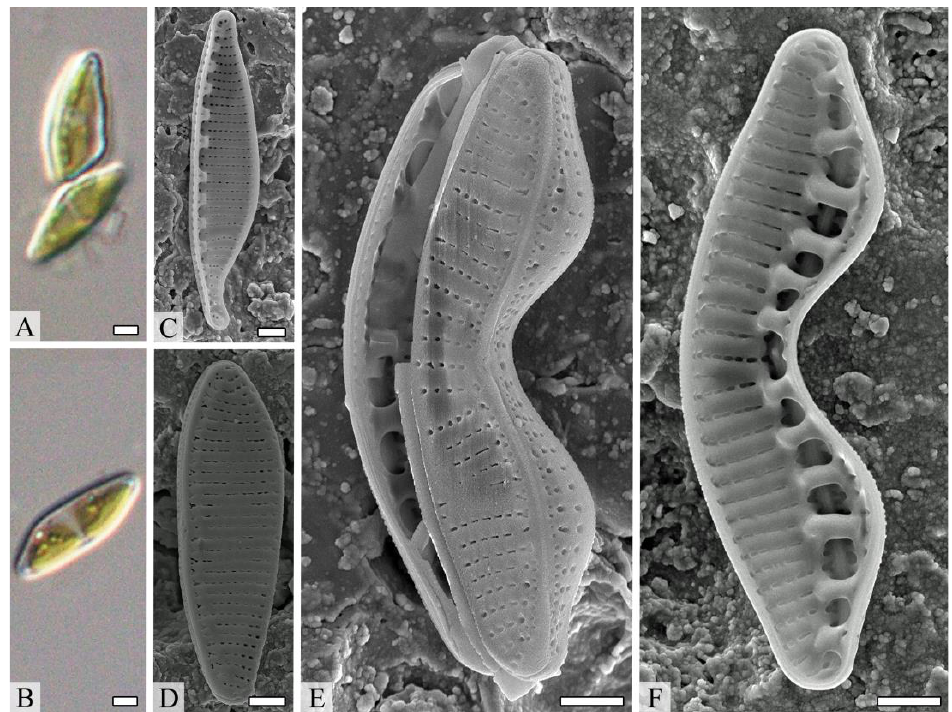
Figure 6. Cells of Nitzschia acidoclinata with asymmetrical and curved morphologies. ( A , B ) Light microscopy. S cale bars = 2 μm . ( C – F ) Scanning electron microscopy. S cale bars = 1 μm.